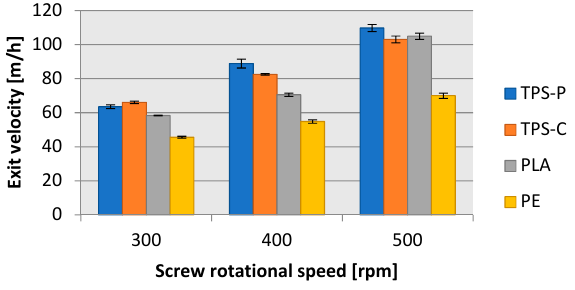
Figure 12. Relationship between film exit velocity on the rotational speed of the extruder screw.